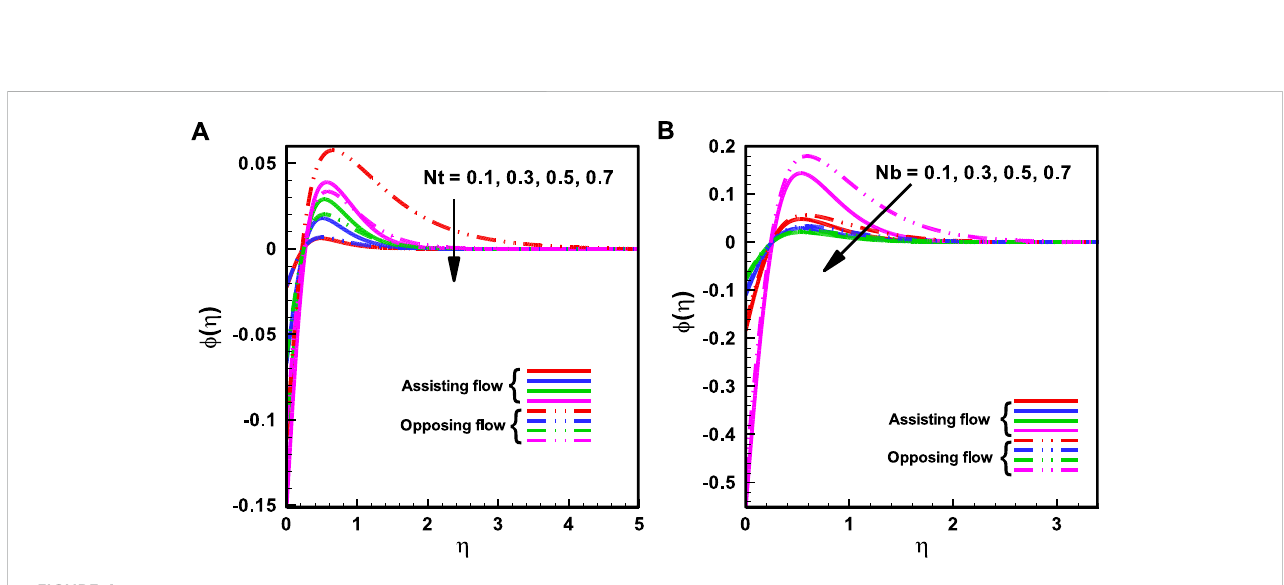
FIGURE 4 Variation of nanoparticles fraction pro fi le (A) . The Thermo-Phoresis Parameter N t . (B) The Brownian Motion Parameter N b .